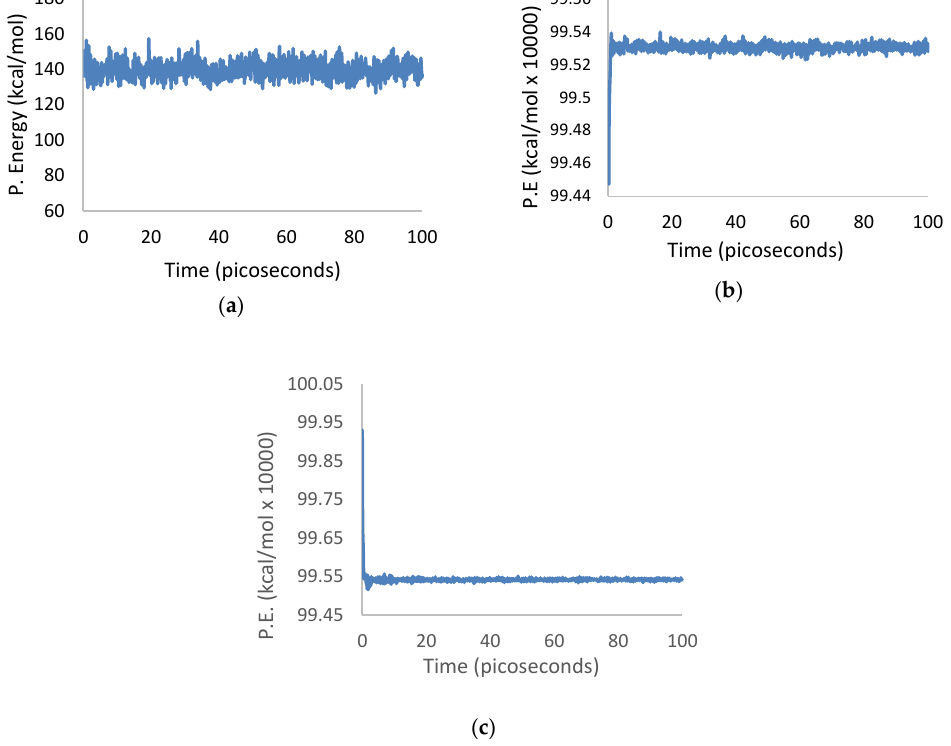
Figure 19. Potential energy equilibration over simulation time of 3PPV and (13,0) SWCNT systems: ( a ) Potential energy vs. time of isolated 3PPV; ( b ) potential energy vs. time of isolated (13,0) SWCNT; ( c ) potential energy vs. time of composite 3PPV–(13,0) SWCNT.